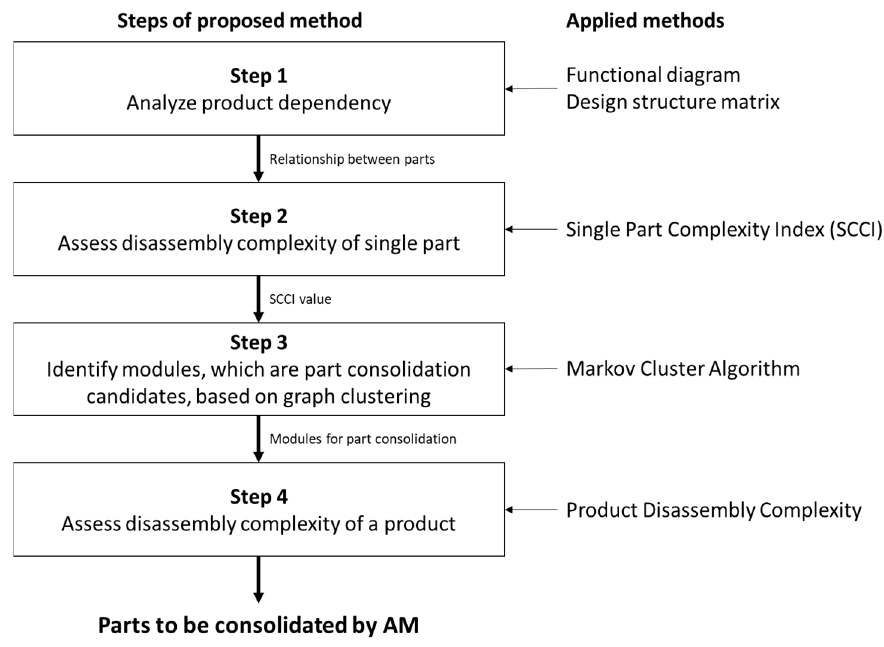
Figure 1. Overview of the proposed design method.